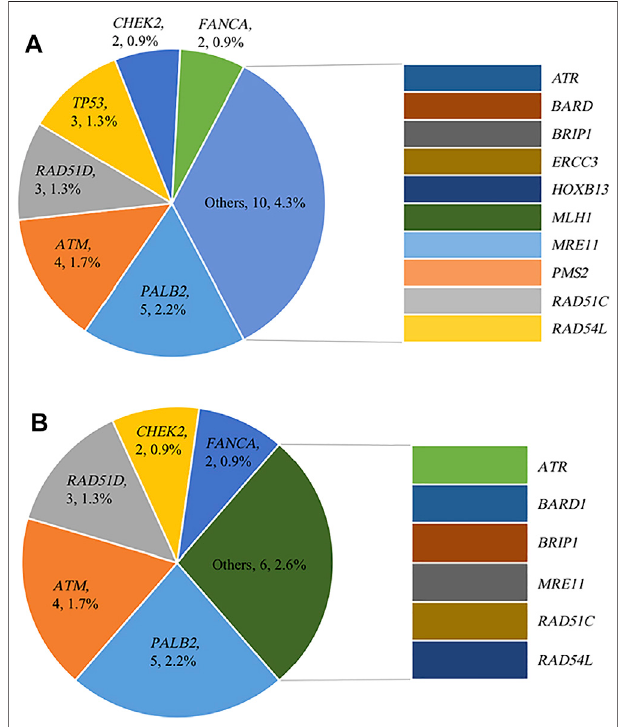
FIGURE 1 | Distribution and frequency of germline mutations (A) Distribution and frequency of non- BRCA gene germline mutations; (B) Distribution and frequency of non- BRCA HRR gene germline mutations.